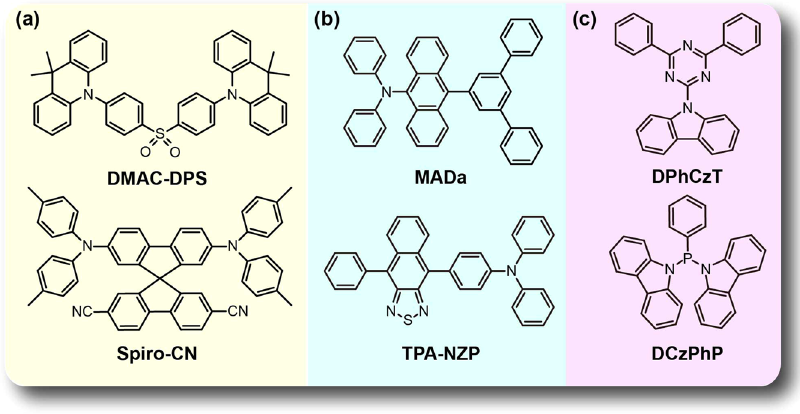
Figure 2. Chemical structures of typical ( a ) TADF ( DMAC-DPS and Spiro-CN ), ( b ) HLCT ( MADa and TPA- NZP ) and ( c ) OURTP ( DPhCzT and DCzPhP )